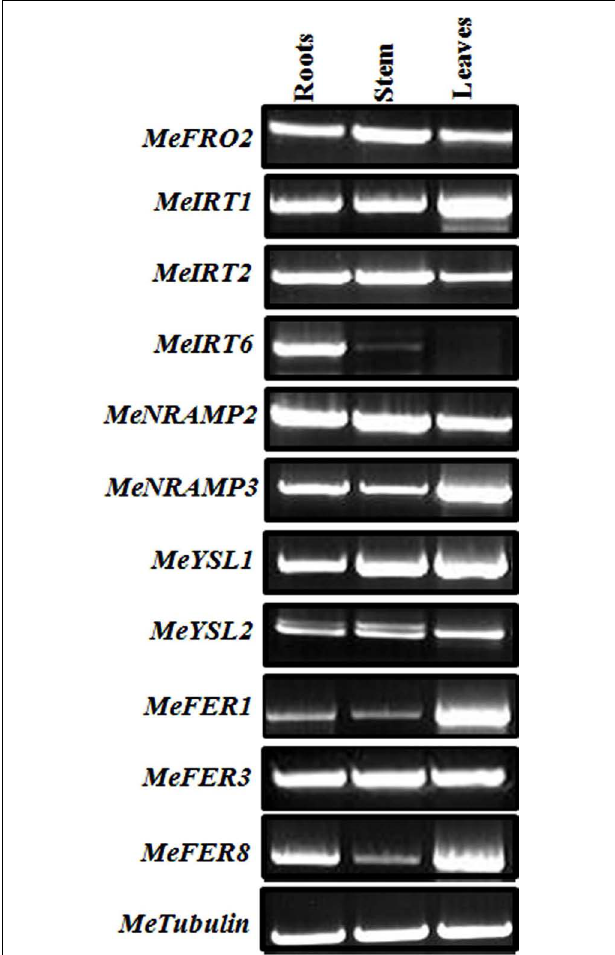
FIGURE 8 | Differential expression of genes involved in iron homeostatis in wild-type cassava. Semi-quantitative RT-PCR analysis of metal regulated transcript abundance and expression of select metal homeostasis genes in wild-type cassava tissues.Tissues (roots, stem, and leaves) were collected at 1.5-month-old in vitro stage. PCR reactions were carried out with gene-specific primers as indicated in Table 1 .Tubulin was used as an internal